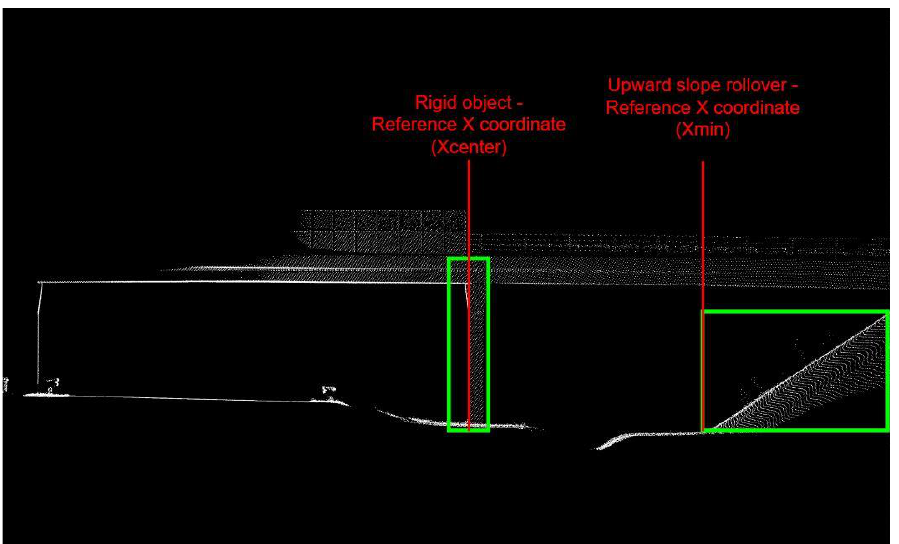
Figure 8. Example of reference X coordinate of rigid object and reference X coordinate of upward slope rollover object.